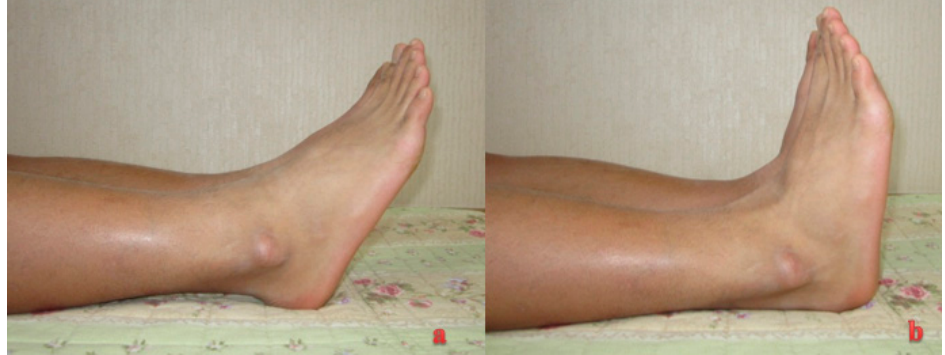
Figure 6. Postoperative clinical outcome (19 months after operation): ( a ) plantar flexion and ( b ) dorsiflexion.